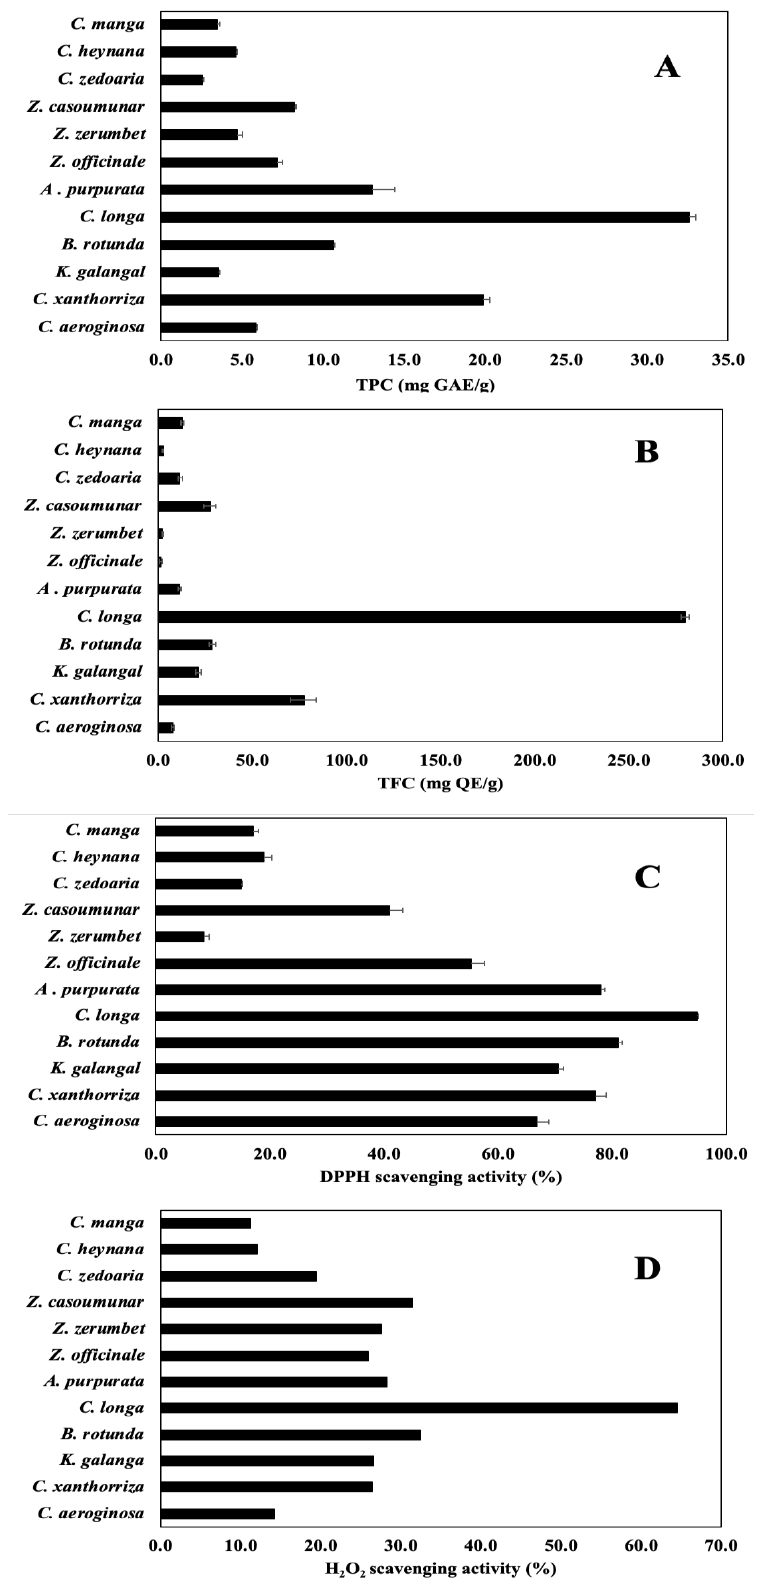
Figure 3. Chemical content and AA in Indonesian herbs: ( A ) TPC by Folin–Ciocalteau assay, ( B ) TFC by NaNO 2 -AlCl 3 -NaOH assay, ( C ) AA, and ( D ) AA (H 2 O 2 ), in 12 Indonesian herbs. ( n = 3, error bars represent standard deviation).